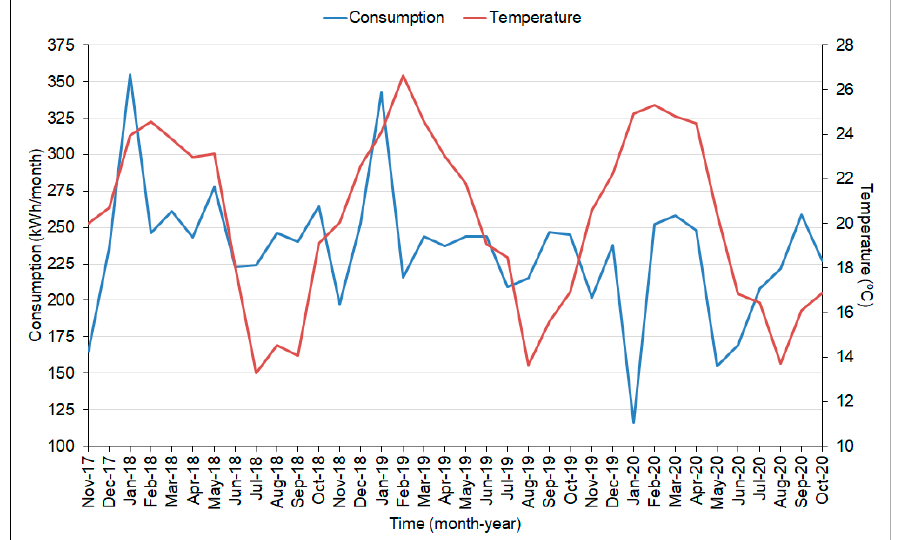
Figure 12. CU-2 Consumption Profile.